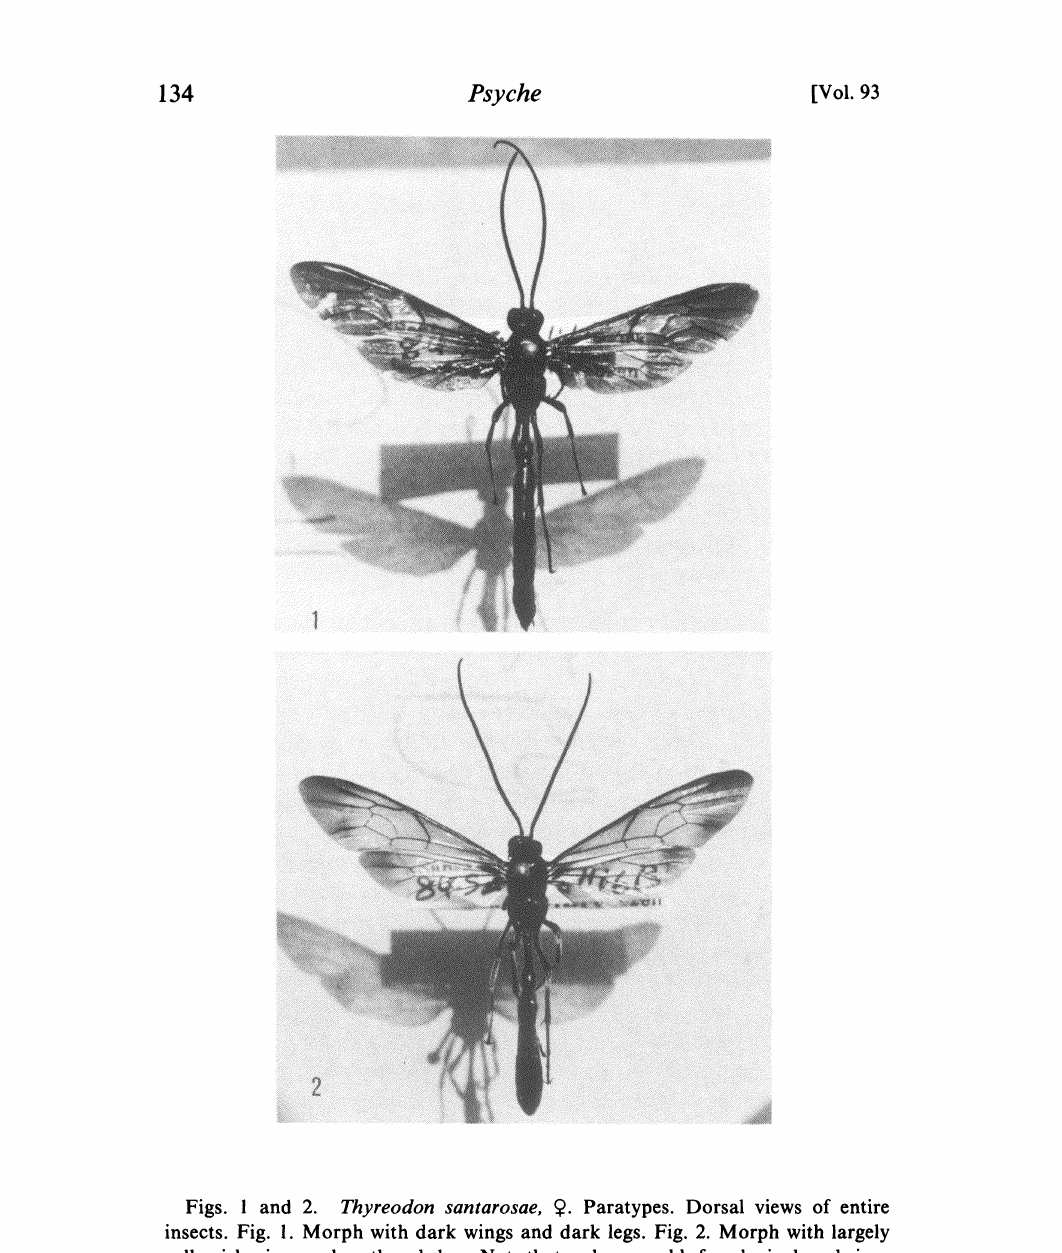
.. Paratypes. Dorsal views of entire Figs. and 2. Thyreodon santarosae, insects. Fig. 1. Morph with dark wings and dark legs. Fig. 2. Morph with largely yellowish wings and partly pale legs. Note that males resemble females in dorsal